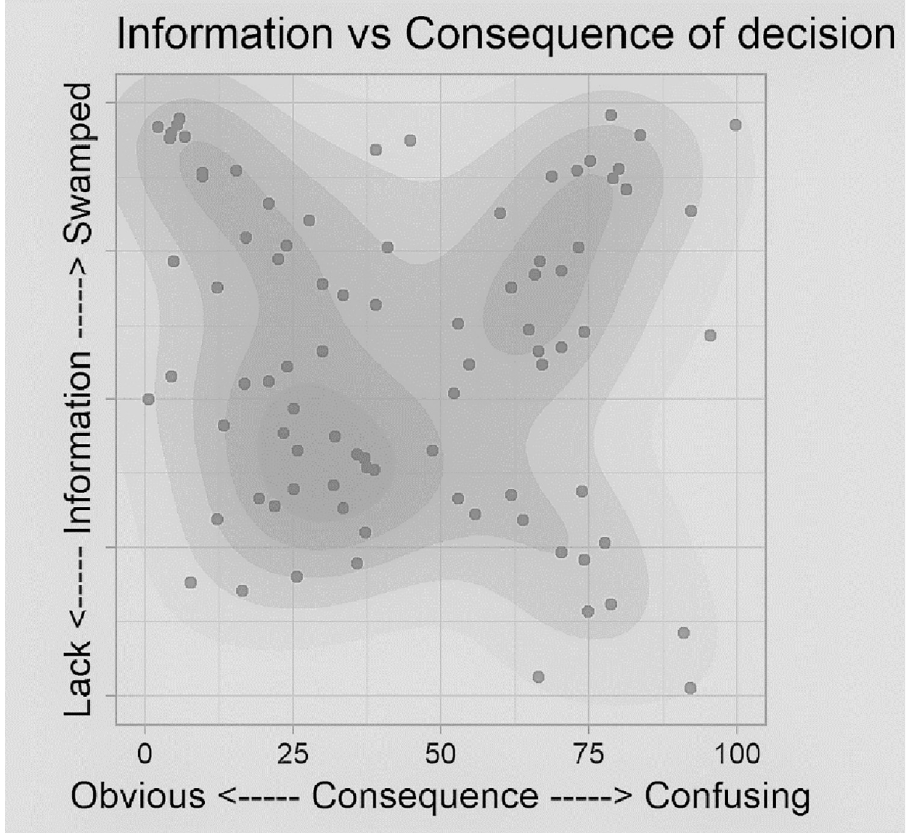
Fig 1. Connection between information flow and the consequences of